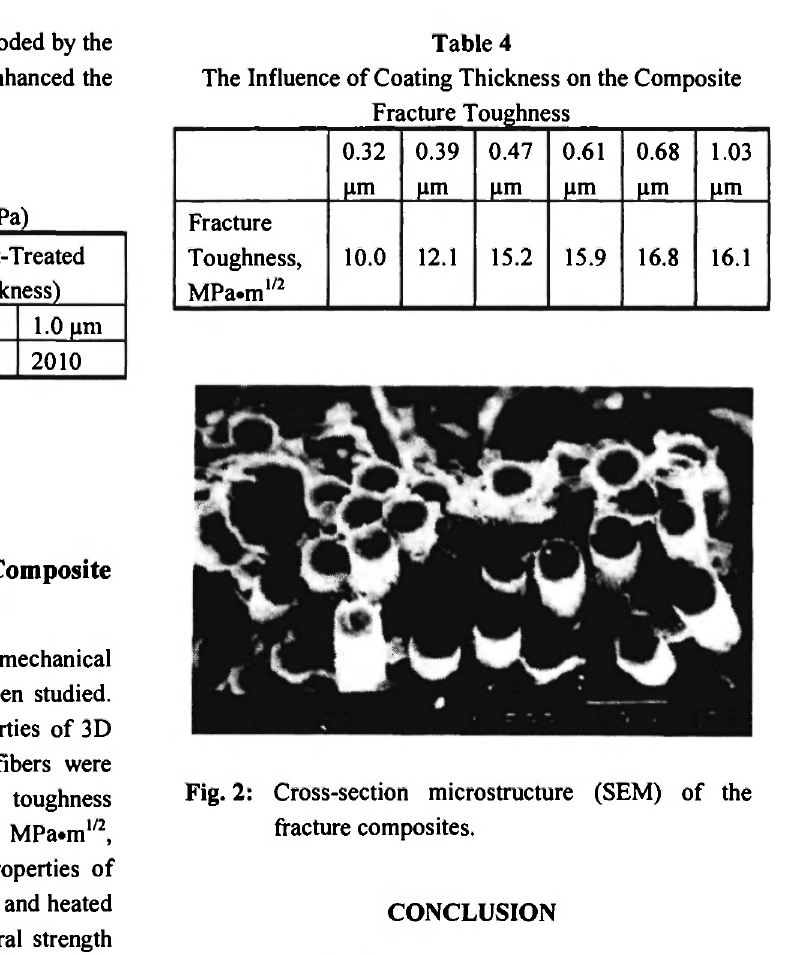
Single Strength of Carbon Fibers (MPa) Heat- Coated and Heat-Treated